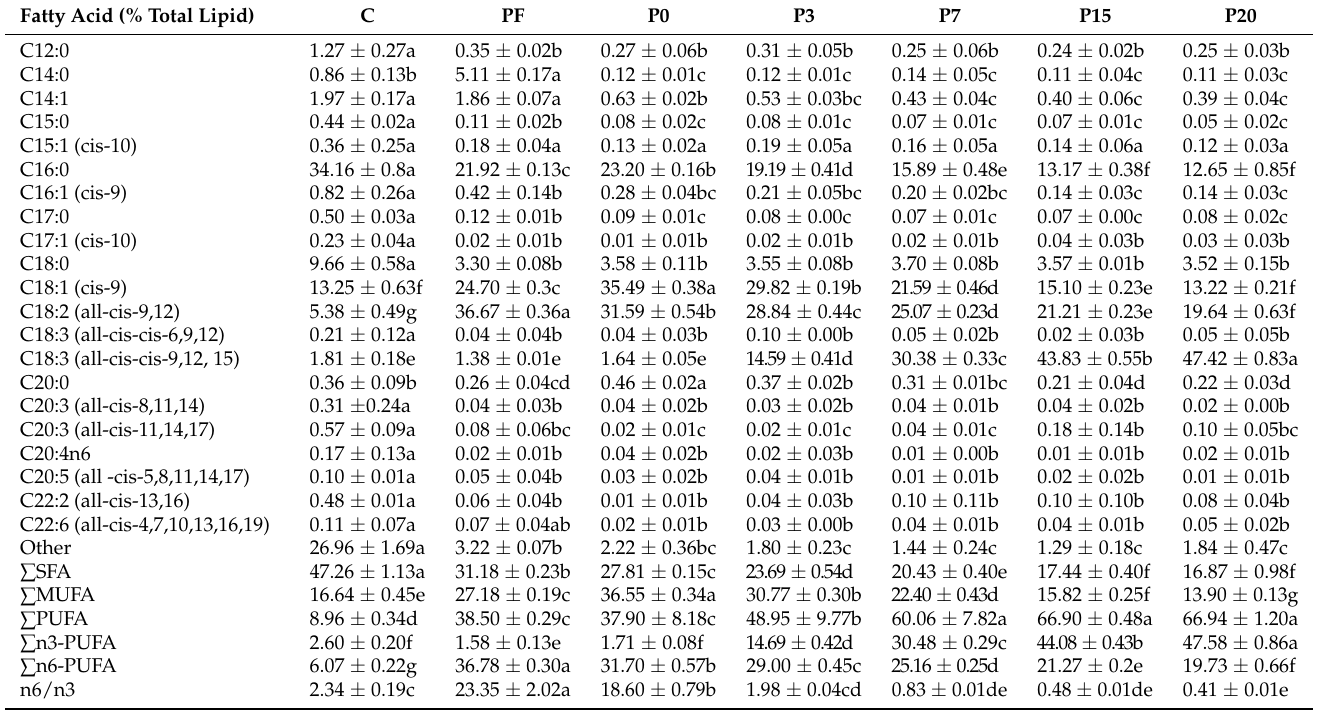
Table 3. Fatty acid composition of experimental diets.